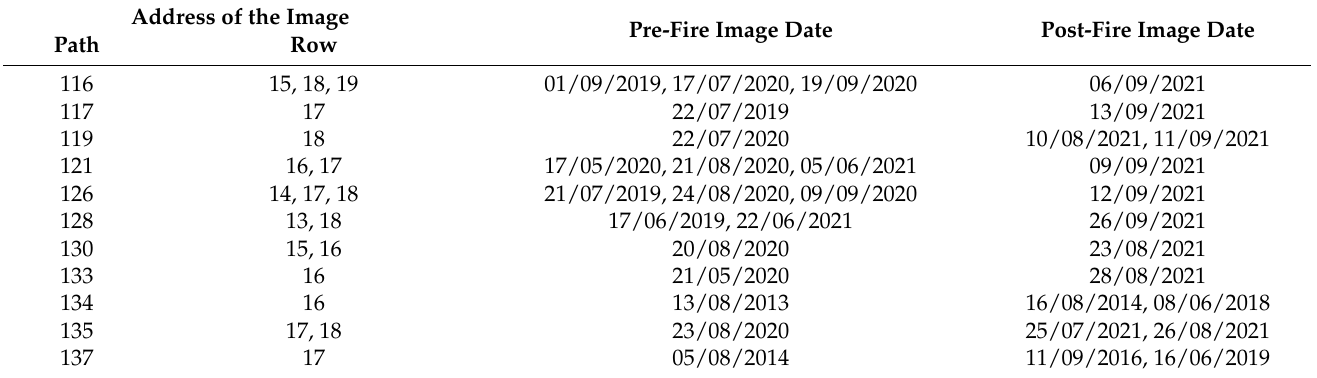
Table 1. The original sample of the Landsat-8/OLI survey, which covered all selected fire